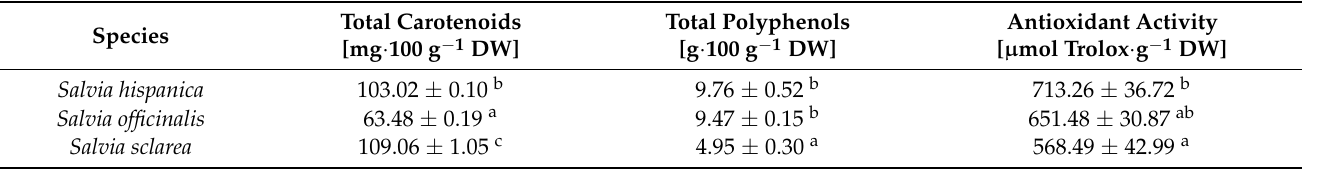
Table 2. The content of bioactive compounds and antioxidant activity in fresh sage of individual